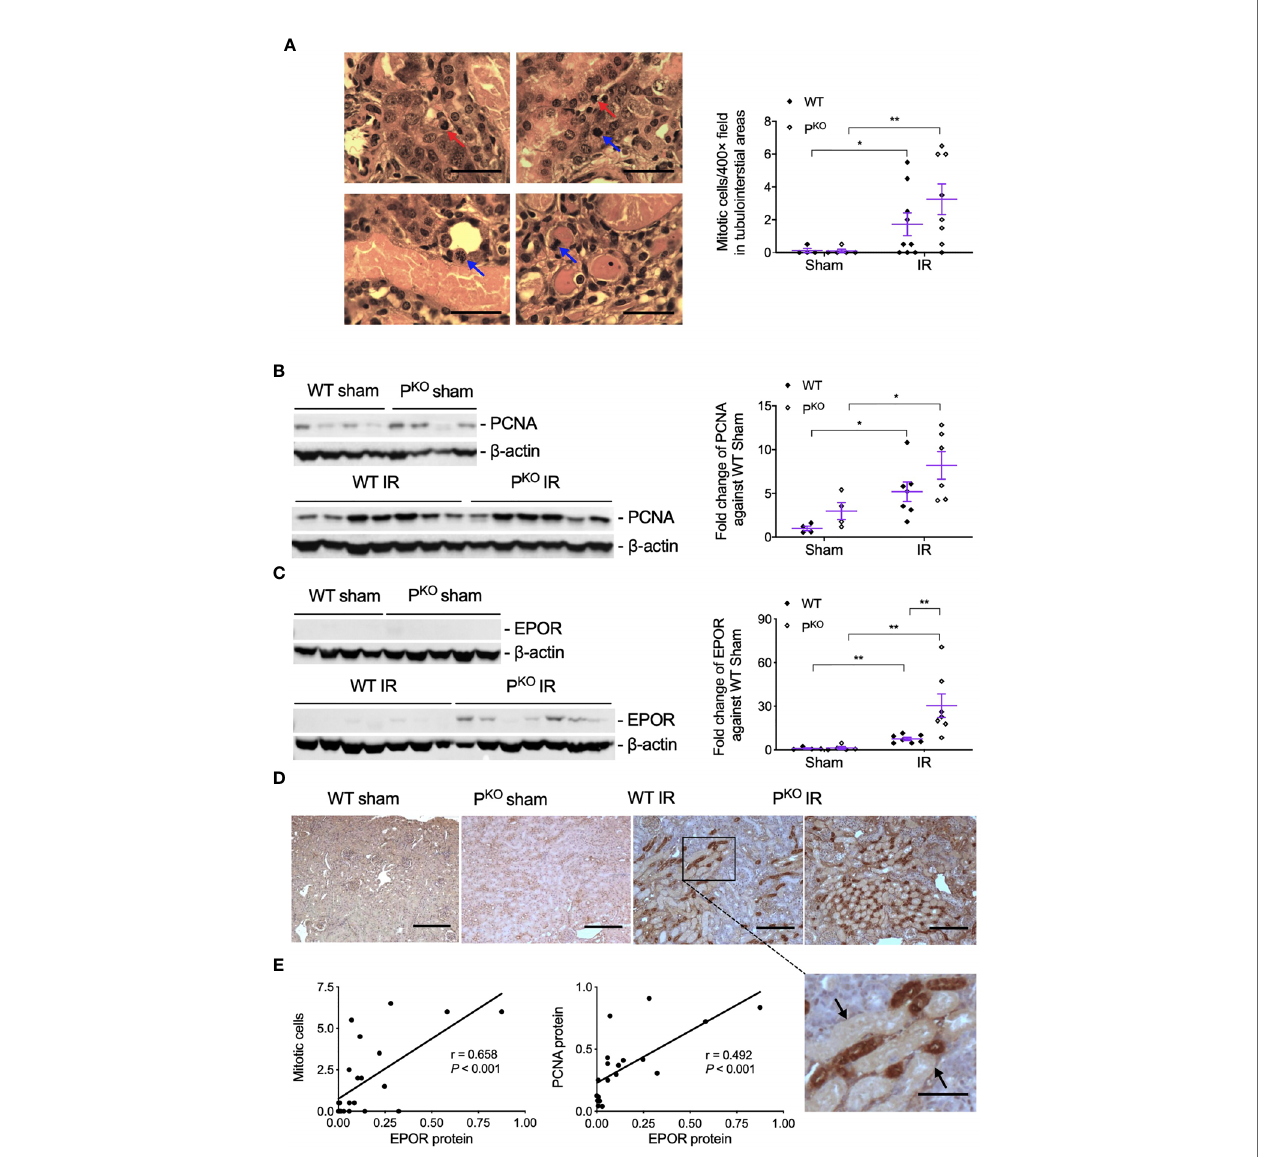
FIGURE 4 | Kidney repair parameters in P KO kidneys post IR at 72 h. (A) Mitotic cells with typical morphological features in tubular and interstitial areas were pointed by blue and red arrows (upper panels, WT IR kidneys; lower panels, P KO IR kidneys). The number of mitotic cells was increased by IR in both WT and P KO mice assessed by semiquantitative analysis. Scale bar: 20 m m. (B) The expression of PCNA protein in the kidney determined by Western blot was increased by IR in both WT and P KO mice. (C) The expression of EPOR protein was also increased in the IR kidneys of both genotypes with a further elevation by P KO compared to WT controls. Data were shown as means ± SEMs and analyzed by one-way ANOVA and LSD test. * p < 0.05; ** p < 0.01. (D) Representative images of EPOR immunostaining in the cortex of kidneys, and the area from a dashed box was enlarged and necrotic tubules were pointed by arrows. Scale bar: 100 and 50 m m (the enlarged image). (E) The linear correlation showed EPOR protein positively correlated to mitosis and PCNA,